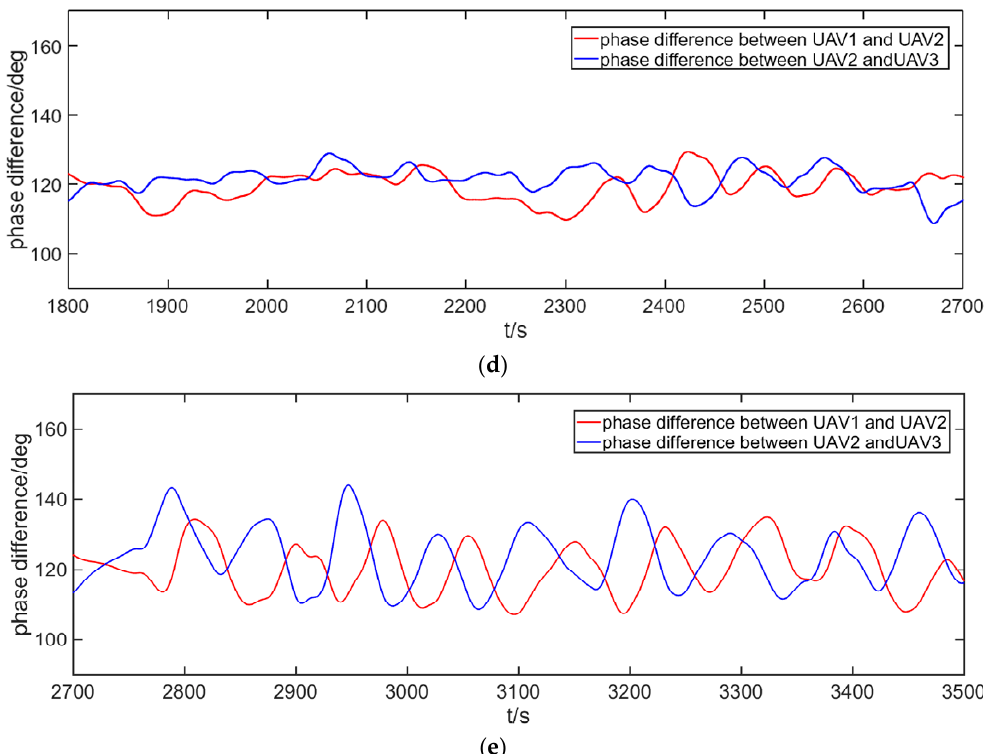
Figure 22. The phase difference. ( a ) Phase difference in the “gathering” stage; ( b ) Phase difference in the “phase adjusting” stage; ( c ) Phase difference in the “high-speed” stage; ( d ) Phase difference in the “low-speed” stage; ( e ) Phase difference in the “accelerating” stage.